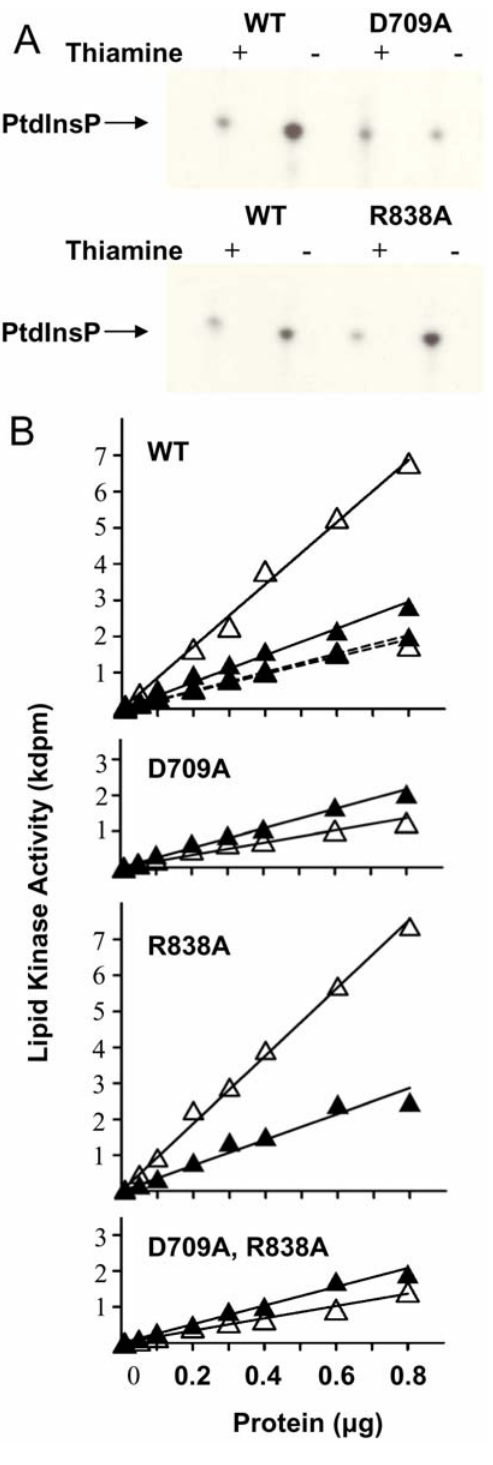
Figure 7. Pik1 D709, but not R838, is required for lipid kinase activity. (A) Incorporation of 32 P into PtdInsP as visualized by autoradiography after chromatographic separation of phospholipids. S. pombe cells were transformed with pREP1 plasmids carrying either full-length wild-type (WT) or mutant (D709A or R838A) pik1 cDNA coding regions under the control of the nmt1 promoter. Cells were cultured in the presence or absence of thiamine as indicated. Cell lysates (0.05 m g total protein) were pulse labeled with [ c - 32 P] ATP. Phospholipids were extracted and subjected to thin layer chromatog- raphy, followed by autoradiography. PtdInsP, monophosphorylated